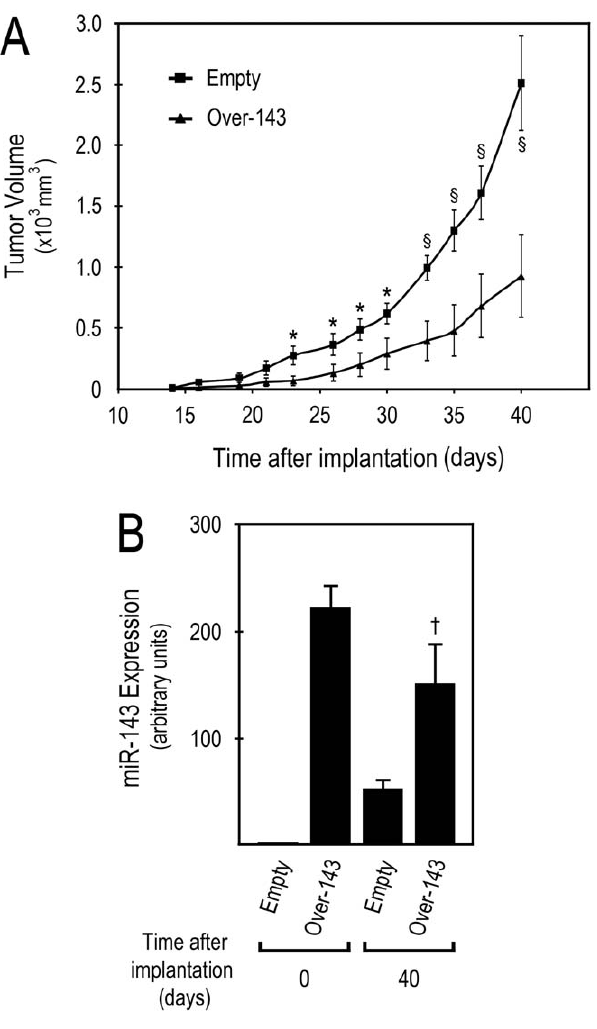
Figure. 2. miR-143 overexpression decreases human colon carcinoma cell tumor xenograft growth in nude mice. Forty- eight hours after release from dual-thymidine block, 5 6 10 5 miR-143 overexpressing ( Over-143 ), or control ( Empty ) cells, were s.c. injected into the flanks of nude mice. A, Tumor xenograft size was regularly measured (every 2-3 days), from the initial signs of tumor development, until the end of the experiment ( , 14 and 40 days after cell implantation, respectively), to plot tumor growth curves. Animals were then sacrificed and tumors excised. B, Total RNA was extracted from Over-143 and Empty cells prior to implantation into animals (t=0 days) and from snap frozen tumor xenograft samples (t=40 days), and used to quantify mature miR-143 expression. miR-143 expression was evaluated from 1.4 m l cDNA of 10 ng total RNA RT reactions, using specific primers for miR-143 and RNU6B for normalization. miR-143 expression levels were calculated by the a˜a˜ C t method, using Empty cells as calibrator. Two independent experiments were performed using a total of 12 animals for Over- 143 and 10 animals for Empty . Results are expressed as mean 6 SEM. * p , 0.05, 1 p , 0.01 from Over-143 and { p , 0.05 from Empty .